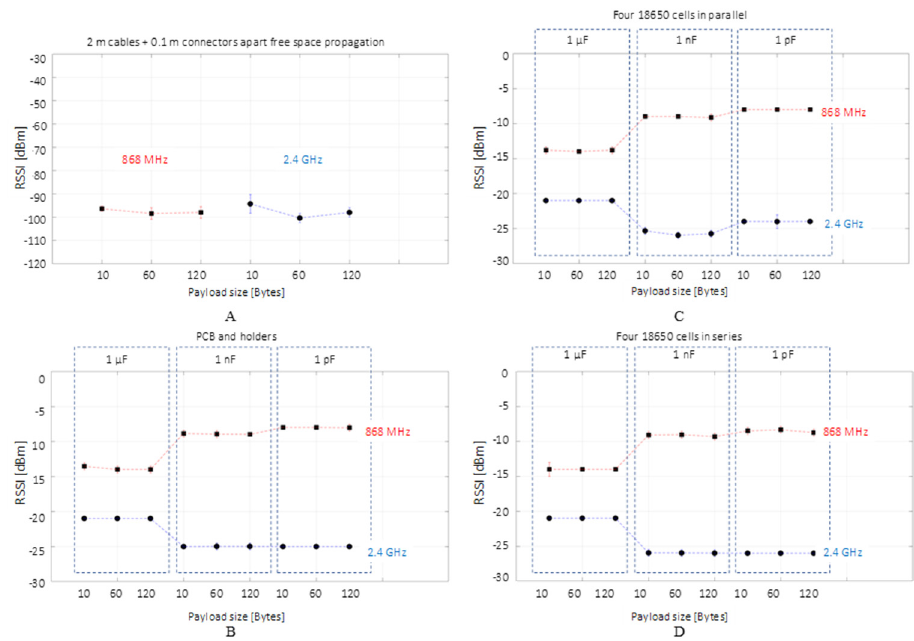
Figure 7. Experimental measurement’s received signal strength indicator (RSSI) for the 868 MHz and 2.4 GHz communication over the 2.1 m separation between the two RF transceivers ( A ), connected to the capacitive coupling PCBs ( B ), linked to the DC bus composed of four Li-ion cells organized in parallel ( C ) and in series ( D ). The square marker shows the average measurement interval value in the context of the min–max range bars.